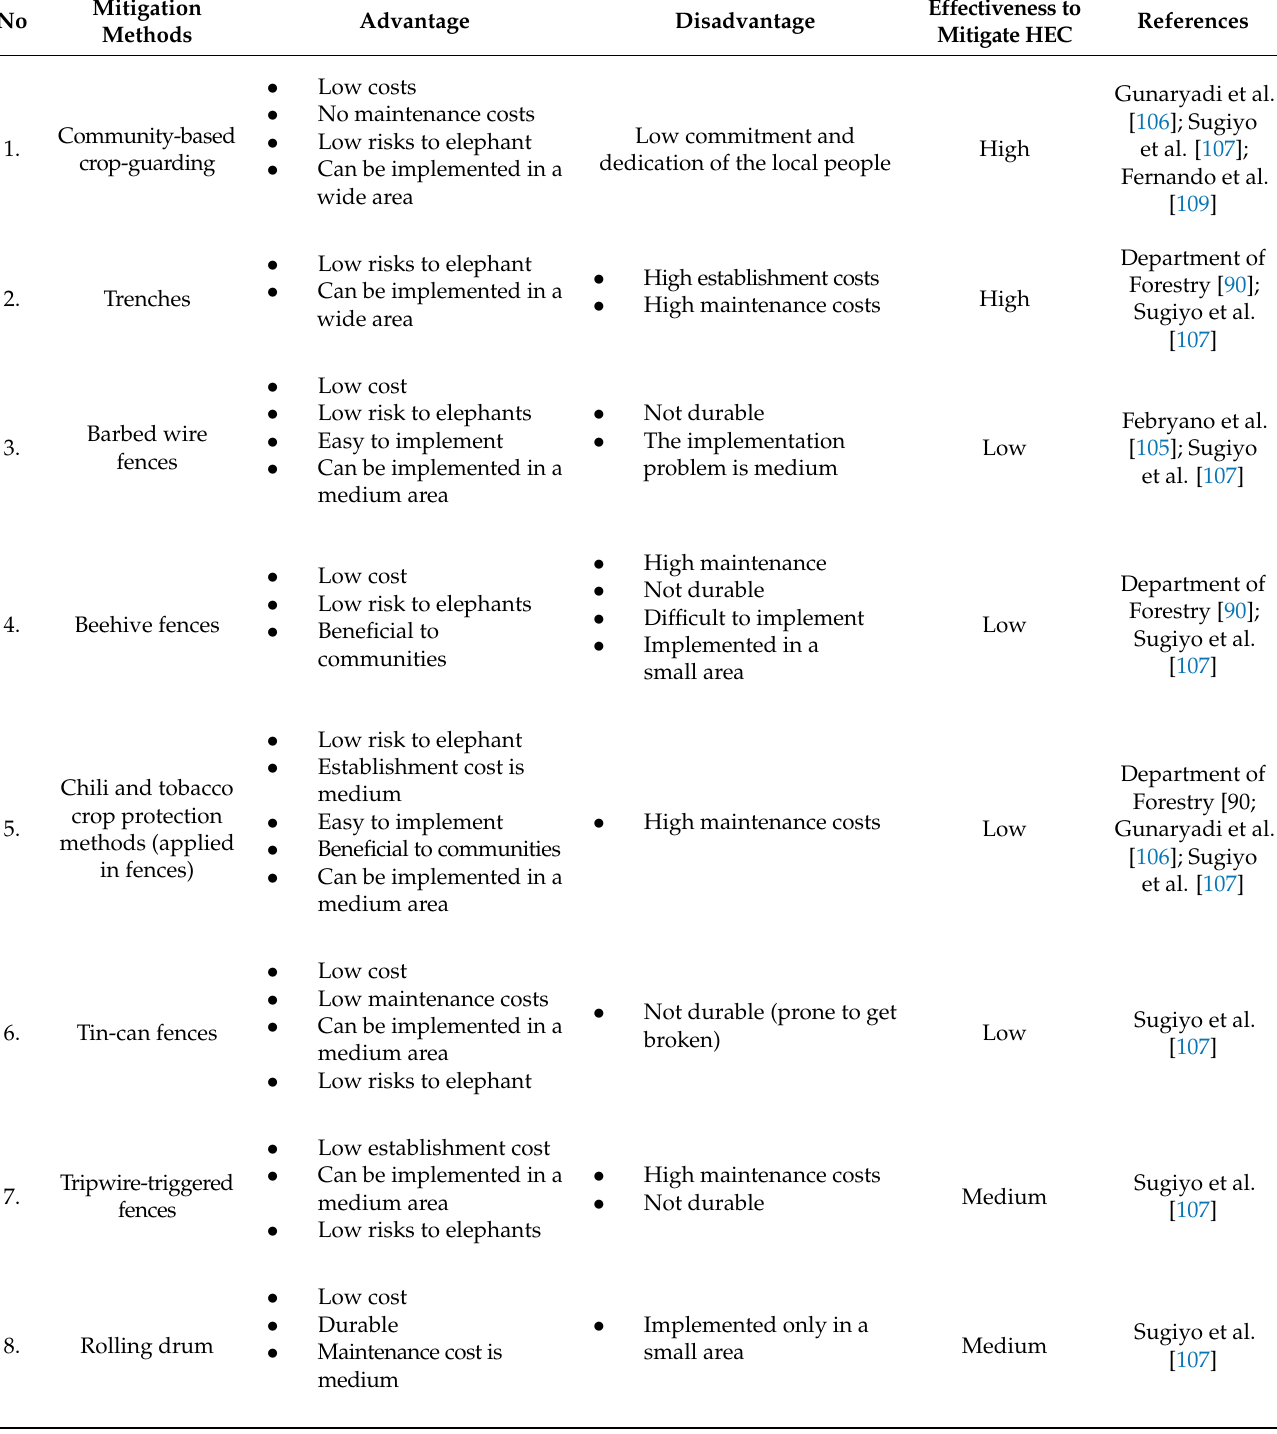
Table 4. Methods of crop raiding prevention in HEC mitigation used in